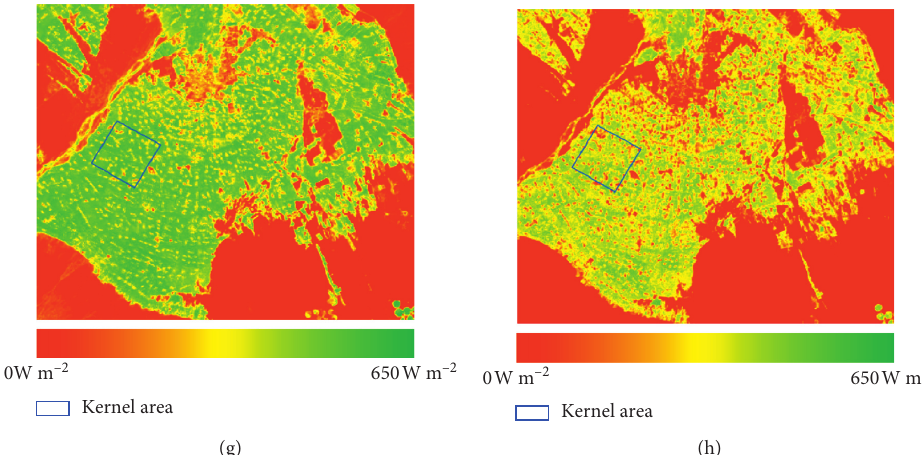
Figure 5: Spatial distribution of LE in eight dates ((a) 15 Jun; (b) 24 Jun; (c) 10 Jul; (d) 2 Aug; (e) 11 Aug; (f) 18 Aug; (g) 27 Aug; (h) 3